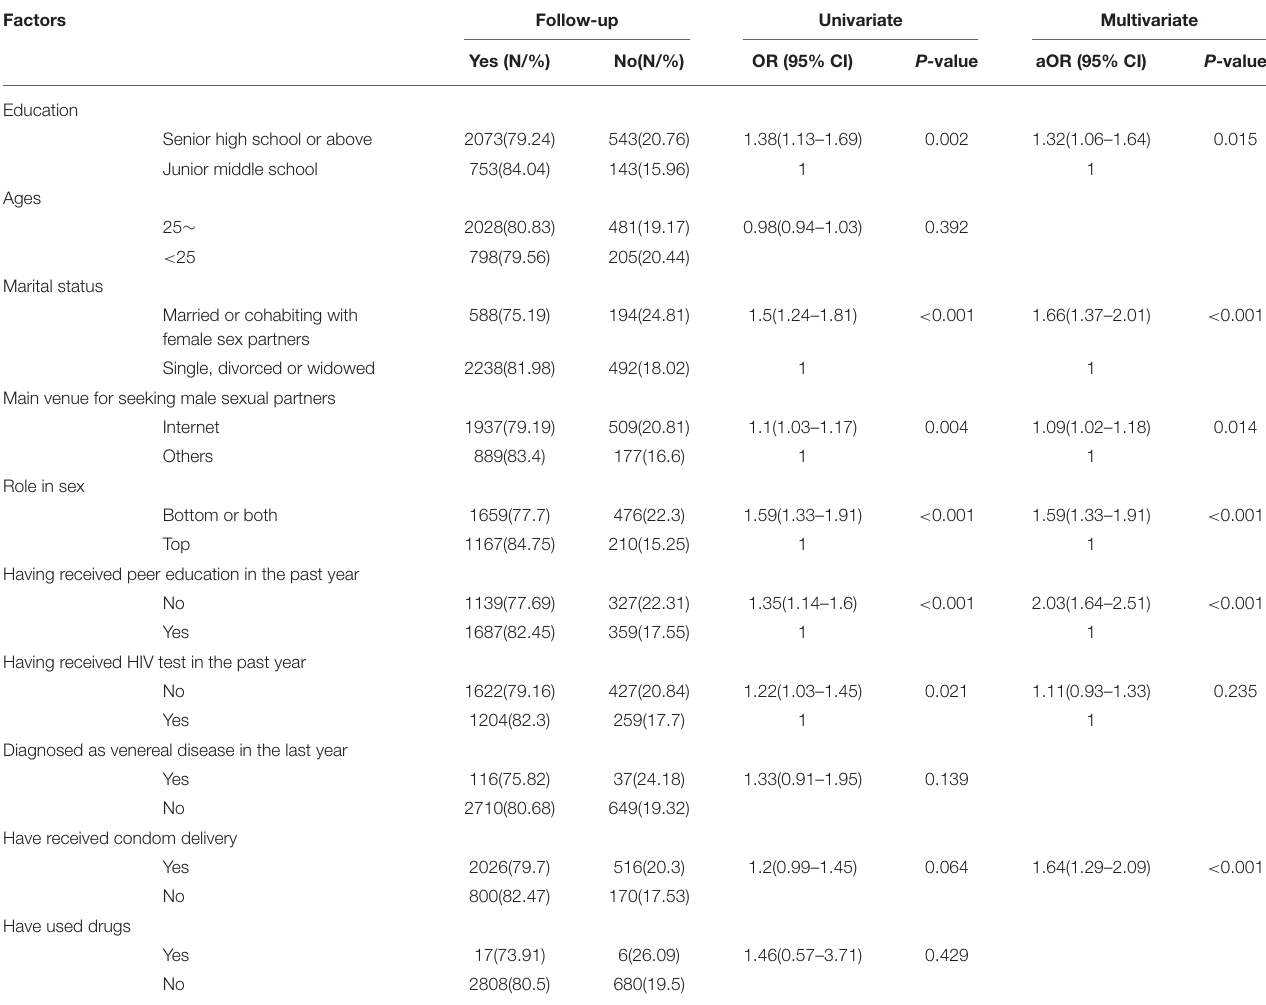
TABLE 4 | Factors associated with loss to follow-up in cohort of MSM in